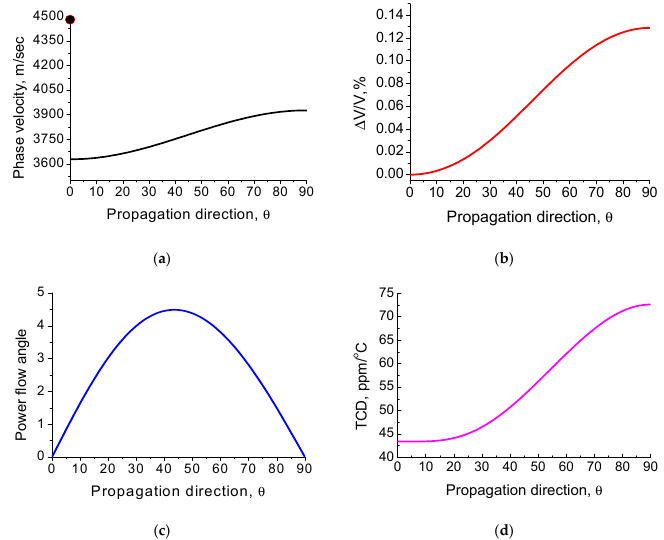
Figure 3. SAW propagation direction dependences from the Y-axis on the X-cut of KTP: ( a ) phase velocity; ( b ) Δ V/V; ( c ) power flow deflection angle (degrees); and ( d ) TCD. The dark circle denotes the BG wave solution.